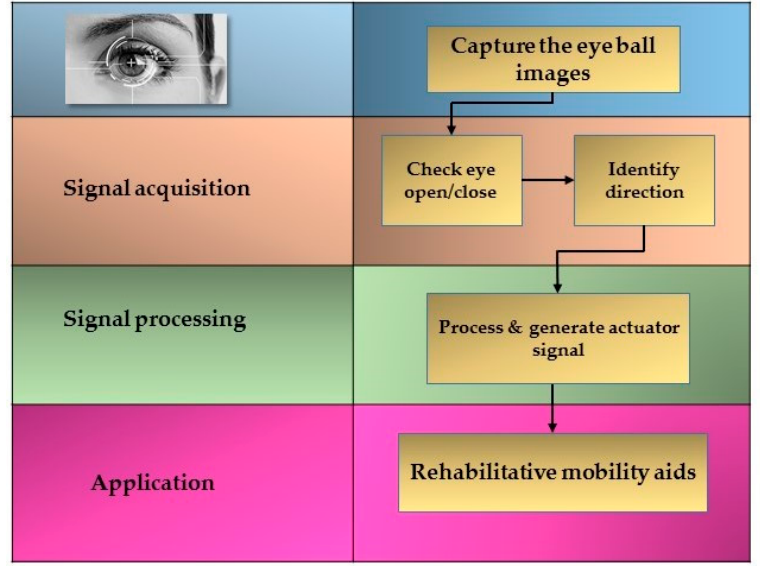
Figure 2. General process flow block diagram.